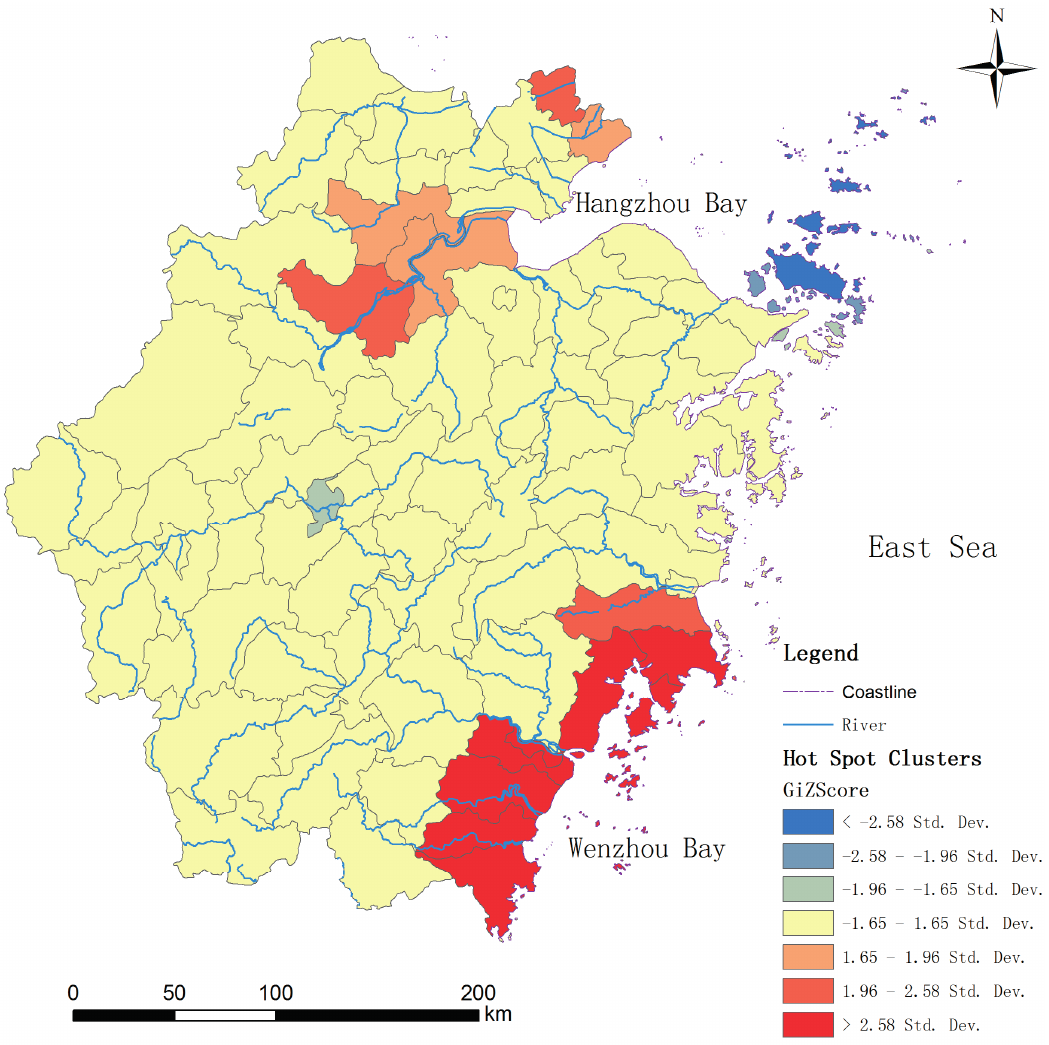
Figure 9. Hot spot clusters of cholera in the study